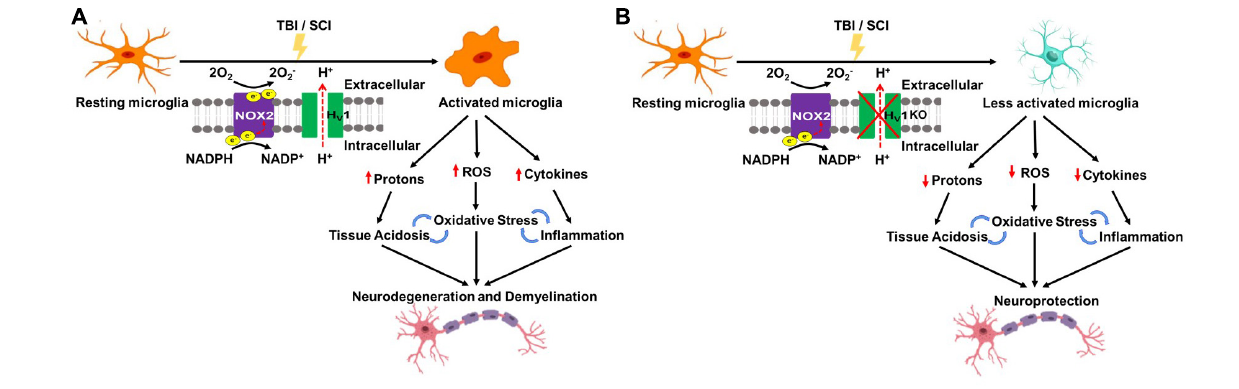
FIGURE 2 | Schematic of Hv1 as a key driver of tissue acidosis, oxidative stress, and neuroinflammation in traumatic central nervous system (CNS) injury. (A) Traumatic brain injury (TBI) and spinal cord injury (SCI) lead to Hv1-driven microglia activation which causes tissue acidosis, oxidative stress, and an increase in proinflammatory cytokine levels. Consequently, there is an increase in neuronal loss, functional deficits, and poor long-term recovery. (B) Hv1 deficiency (KO) limits microglia activation and thereby rectifies trauma-induced reductions in environmental pH, abolishes ROS production, ameliorates neuroinflammation, and as a result, slows the progressive worsening of neuronal injury and functional deficits following